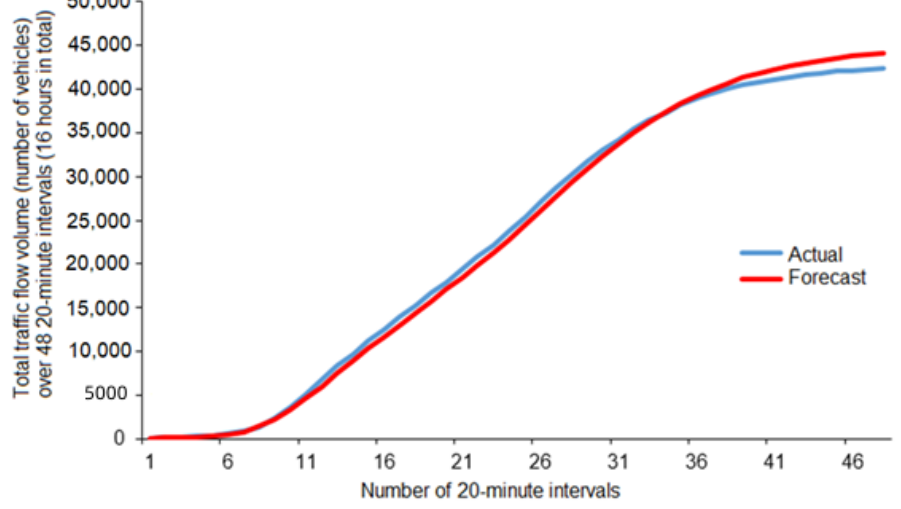
Figure 11. Actual and forecast total traffic flow volume (number of vehicles) over 48 20-min intervals (16 h in total).